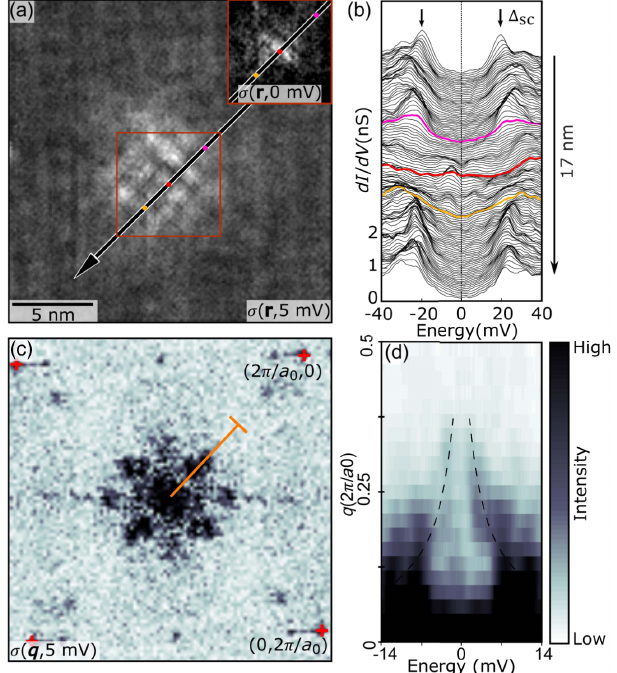
FIG. 1. Electronic structure of a vortex core on heavily OD Bi2212 ( T c ≈ 52 K) at 3 Tesla. (a) Low-energy conductance map σ ð r ; 5 mV Þ showing the roughly 4 a 0 × 4 a 0 charge density modulation in the vortex halo. The region outlined in red is imaged at 0 mV in the inset to identify the vortex center (red dot). (b) Differential tunneling conductance spectra measured along the trace through the vortex center in panel (a) (the scale corresponds to bottom spectrum; other spectra are offset for clarity). The pink and orange spectra delimit the core region where the SGS develop and the superconducting coherence peaks are suppressed. (c) Fourier transform of (a), where the lattice peaks at q 0 and the periodic modulations at about 0 . 24 q 0 and 0 . 75 q 0 are clearly resolved. (d) Energy dependence of the Fourier amplitude along the orange trace in panel (c), showing the roughly 0 . 24 q 0 checkerboard dispersion. Dashed lines are guides to the